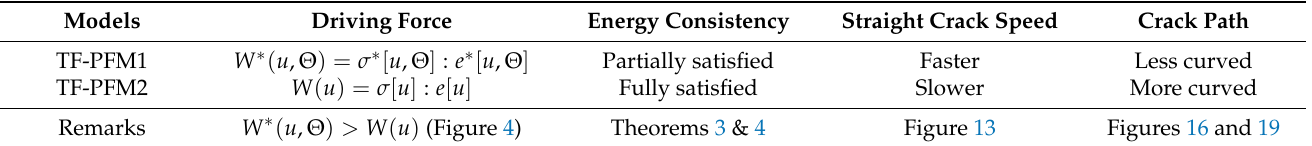
Table 5. Numerical comparison of TF-PFM1 and